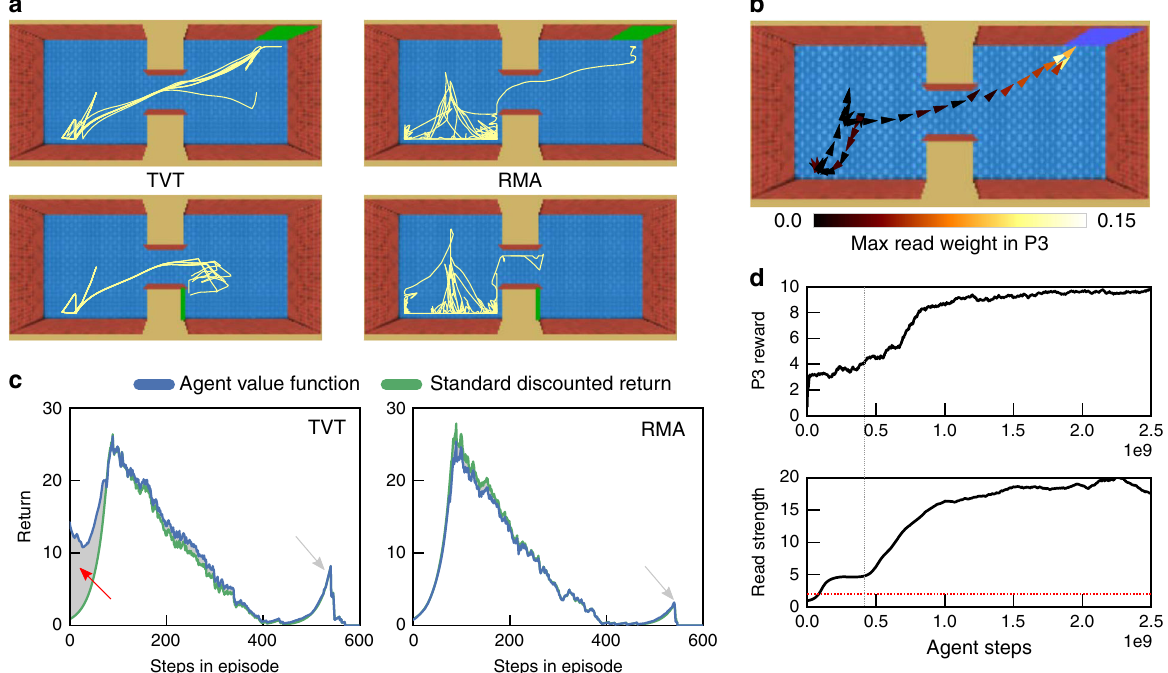
Fig. 3 Analysis of agent in Active Visual Match. a In P1, TVT trained on Active Visual Match actively sought out and oriented to the colored squared. RMA meandered randomly. b Its attentional read weights focused maximally on the memories from time points when it was facing the colored square. c With statistics gathered over 20 episodes, TVT ’ s average value function prediction in P1 (blue) was larger than the actual discounted reward trace (green) — due to the transported reward. Difference shown in gray. The RMA value function in contrast matched the discounted return very closely. d The P3 rewards for TVT rose during learning (upper panel) after the maximum read strength per episode fi rst crossed threshold on average (lower panel, red